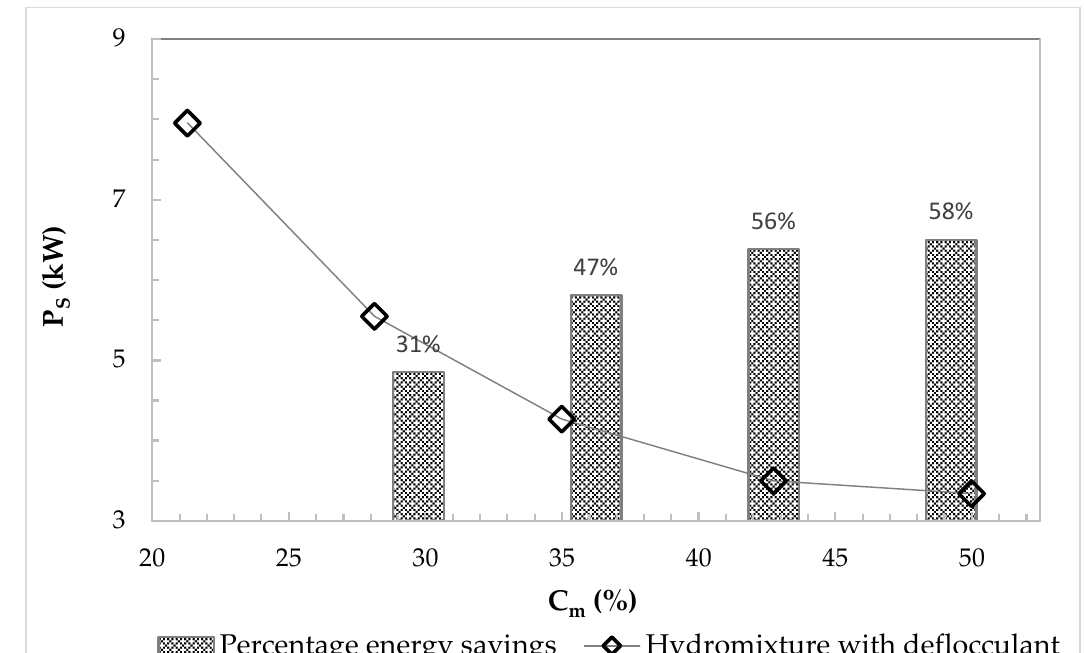
Figure 5. The electricity consumption during pumping of the hydromixture.